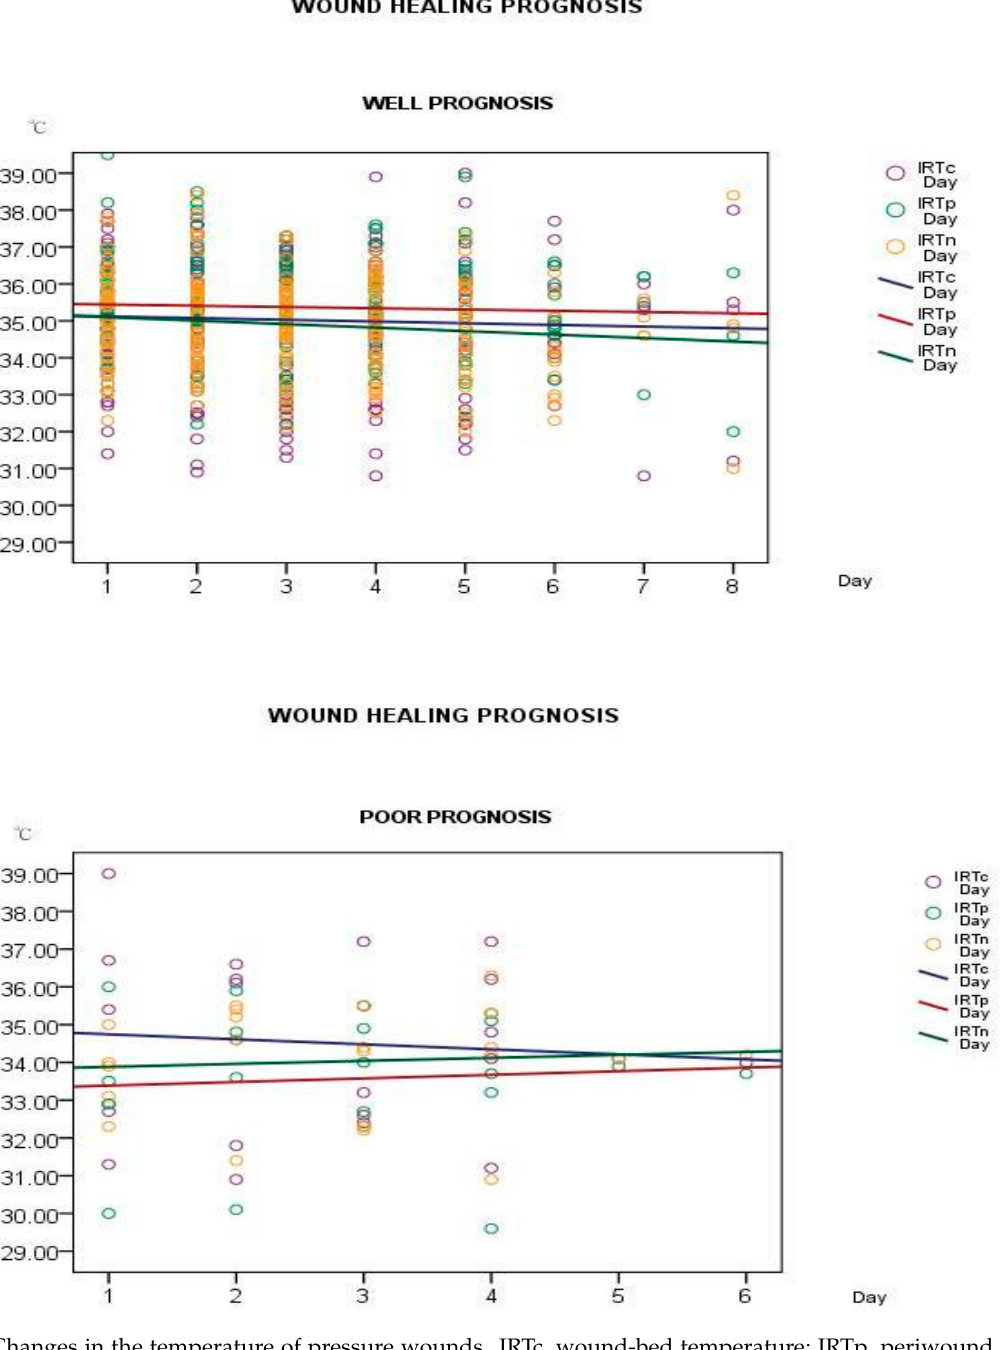
Figure 2. Changes in the temperature of pressure wounds . IRTc, wound-bed temperature; IRTp, periwound skin temperature; IRTn, normal skin temperature. The upper picture showed the temperature change in better wound healing. Periwound skin temperatures (red line) were higher than wound-bed temperatures (blue line) and normal skin temperatures (green line). The mean periwound skin temperature was more than 35 °C. The lower picture showed the temperature change in poor wound-healing. Periwound skin temperatures (red line) were lower than wound-bed temperatures (blue line) and normal skin temperatures (green line). The mean periwound skin temperature was less than 34 °C. When we changed the frequency of observation to once every three days (Table 4), the nutritional status (MUST scores) and temperature of the periwound skin (IRTp) remained correlated with